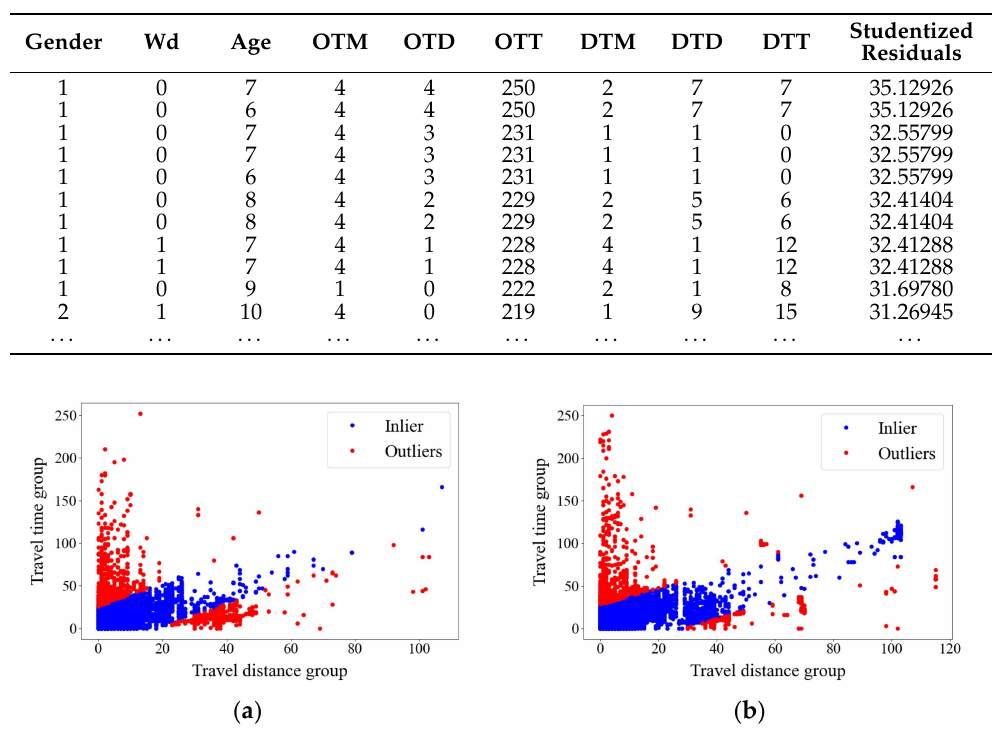
Table 8. Identification of abnormal value based on the variables of origin travel distance and time (May 2021).